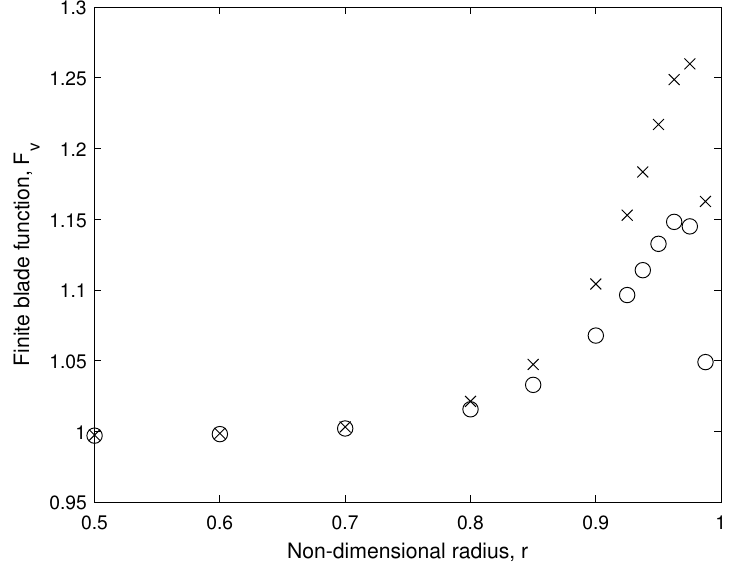
Figure 4. Radial finite blade function, F v from Biot-Savart calculation with Equation (12) for conditions in Table 1, p = 0.1; . F v for p = 0.1 but constant t = 1, . ⃝ ×